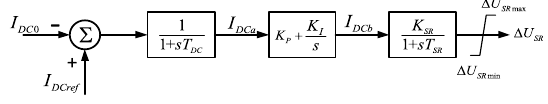
Fig.4 A direct side current control model of